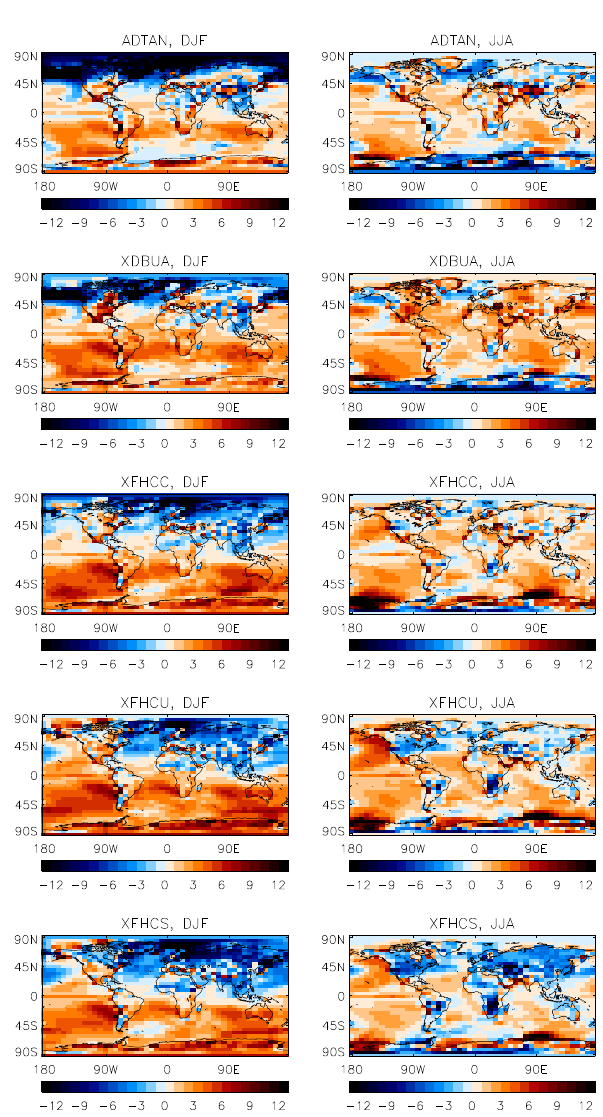
Fig. 10. Air temperature at 1.5m with respect to HadCM3 for pro- gressively more modern versions of FAMOUS (most recent at the bottom of the figure) for DJF (left) and JJA